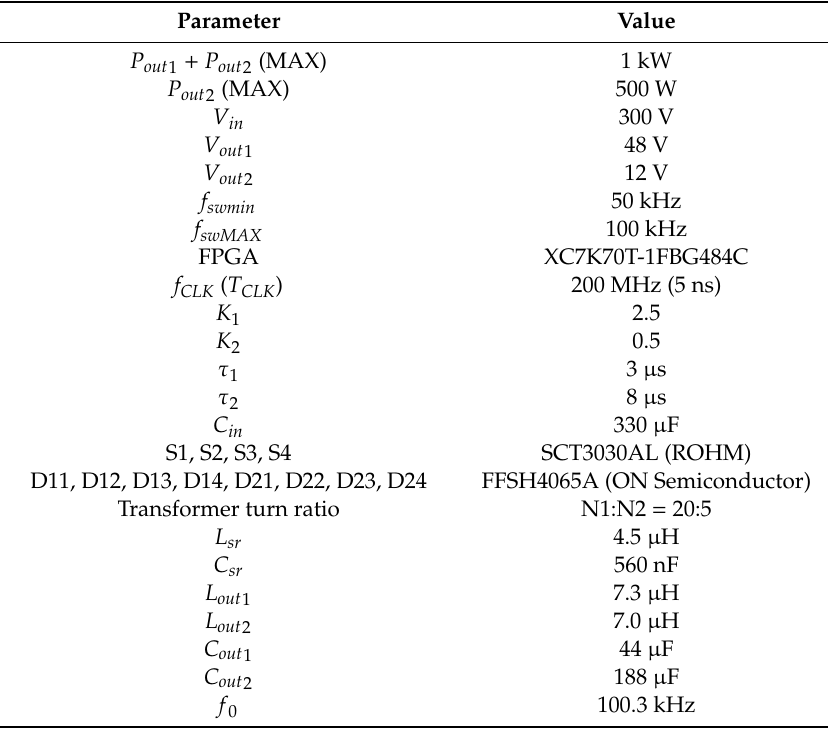
Table 1. Specifications of experimental